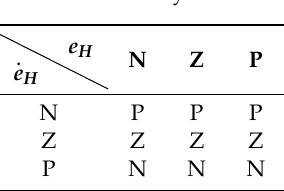
Table 3. Particle swarm optimization (PSO) parameter. Parameter